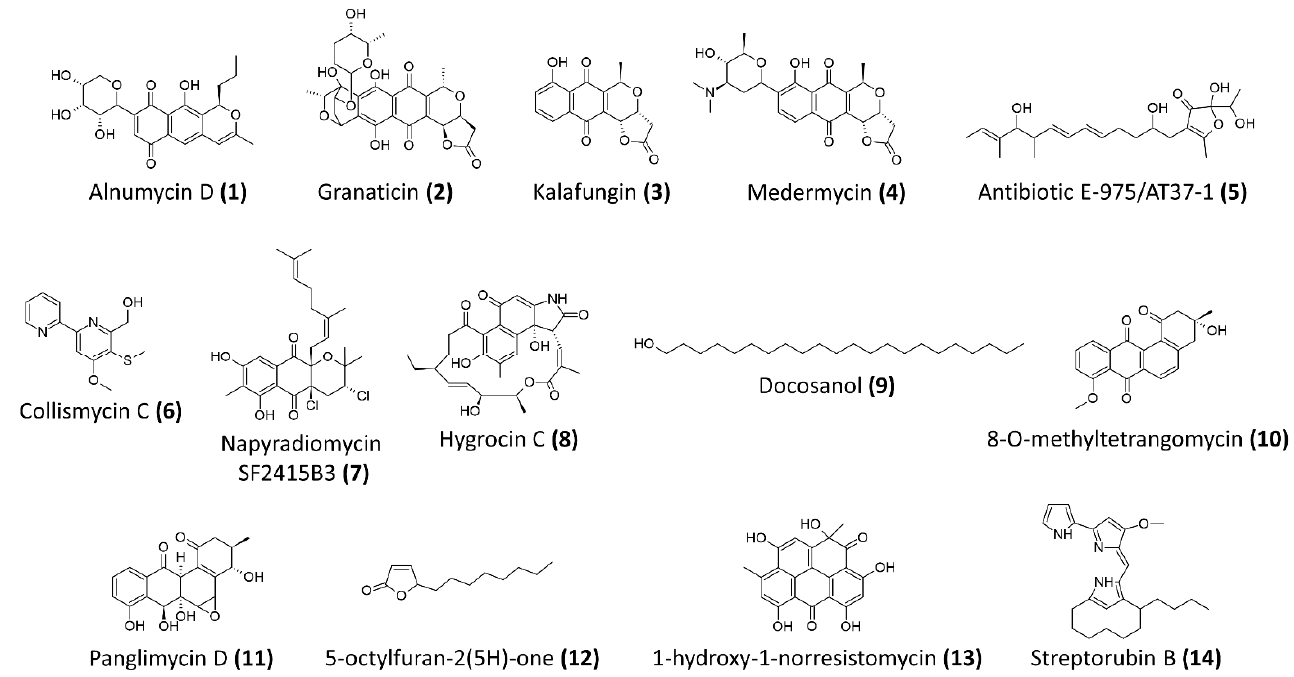
Figure 1. The chemical structures of antibiofilm compounds derived from Streptomyces sp. Alnumycins are pyranonaphthoquinone polyketides recently isolated from Strepto- myces bacteria that exhibit antibiofilm activities against S. aureus. Among the alnumycins isolated from the different strains of Streptomyces albus , alnumycin D ( 1 ) exhibited 100% killing of S. aureus biofilm cells at 40 µ M [63]. Interestingly, alnumycin D ( 1 ) demonstrated strong efficacy in inhibiting preformed biofilms and planktonic growth with IC 50 measured at 2.66 µ M and 1.75 µ M, respectively. Similar to another pyranonaphthoquinone polyke- tides, granaticin B ( 2 ), which was isolated from Streptomyces violaceoruber Tü22 in the study, alnumycin D ( 1 ) was shown to be as highly active as granaticin B ( 2 ), and both were equally efficacious against biofilm cells and planktonic cells [63]. A further comparison was per- formed, in terms of the antibiofilm activity between several other pyranonaphthoquinone polyketides, such as kalafungin ( 3 ) and medermycin ( 4 ) (all was isolated Streptomyces bacteria), and suggested that the oxygenation pattern of the lateral naphthoquinone ring on these compounds has a significant impact on the antibiofilm potency